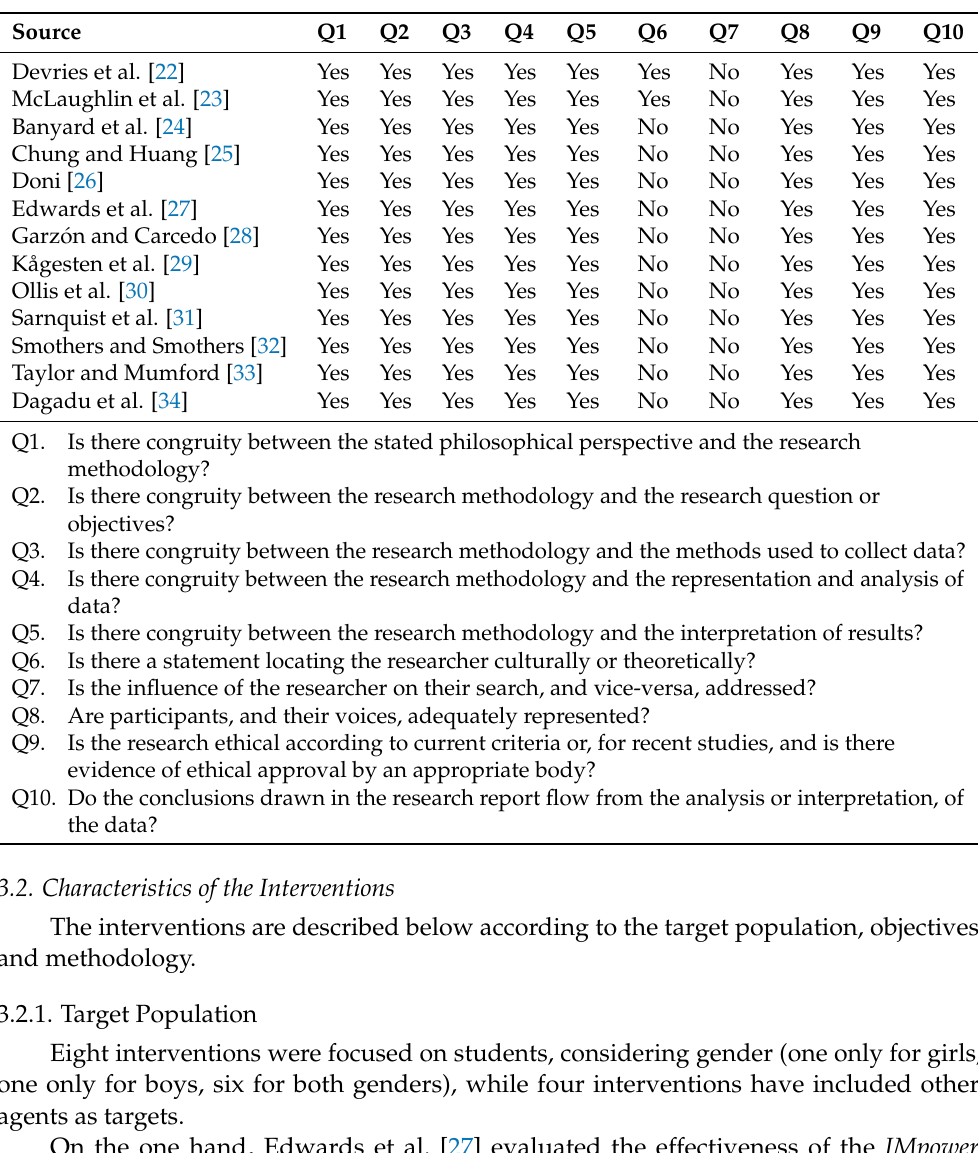
Table 3. Quality of